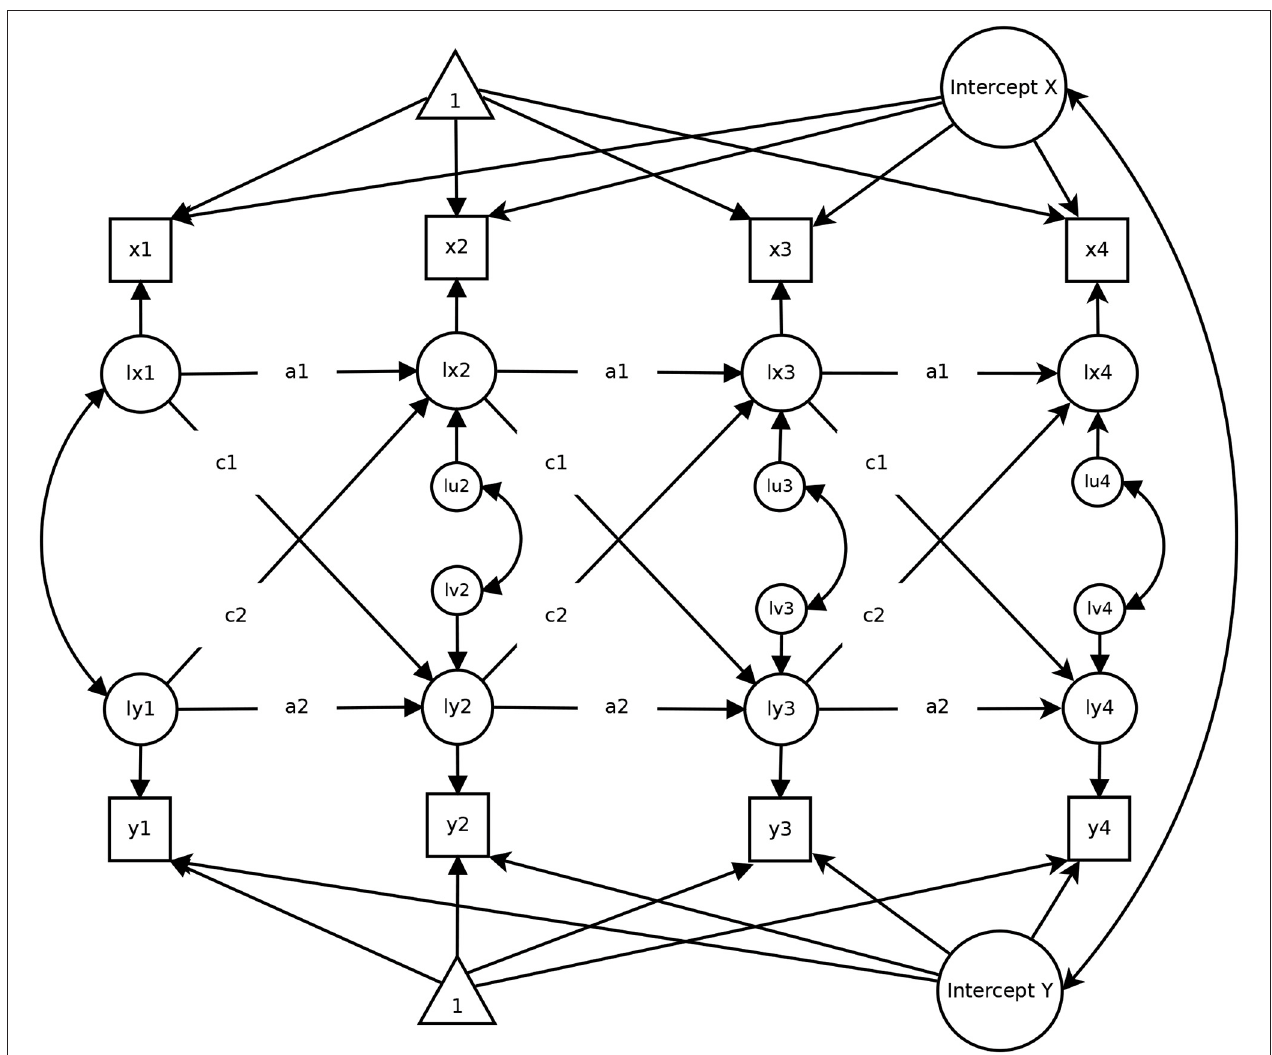
FIGURE 2 | A Random-Intercept Cross-Lagged Panel Model with four measurement occasions. The figure has been published in Mund and Nestler (2019) under a CC-BY 4.0 license and is available at https://osf.io/sjph7/.